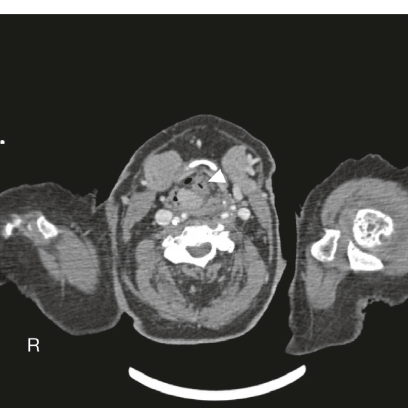
Figure 1: Contrast-enhanced computed tomography scan of the neck shows a large (18 × 22 × 12mm) solid hypopharyngeal-laryngeal mass with well-defined margins, originating from the right pyriform sinus with partial contralateral extension (white arrow).